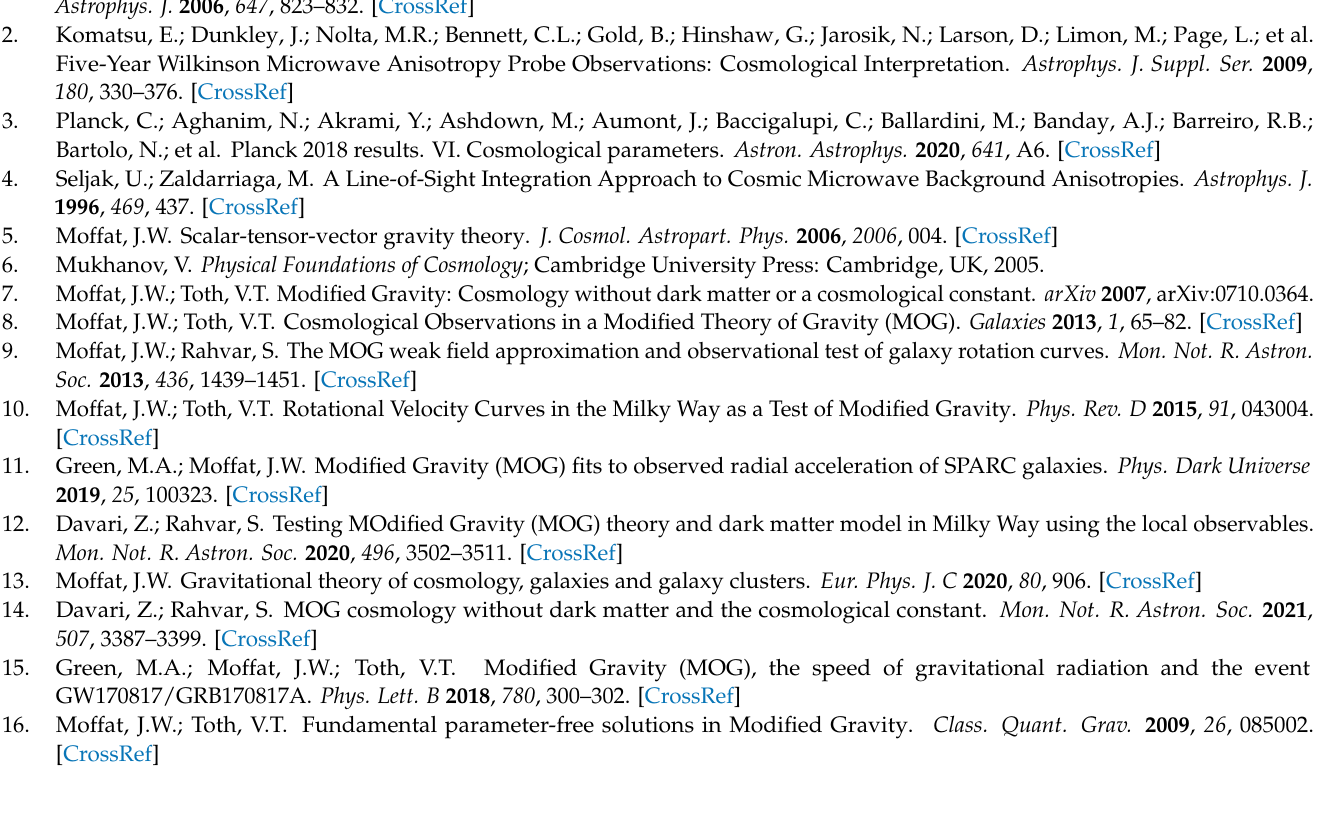
Note the slight changes in the coefficients in Equations (22) and (24) compared to the value published in [6]. We used best fit values for these coefficients from Mukhanov’s approximation using the Planck collaboration’s best estimates for the parameters of the standard Λ CDM